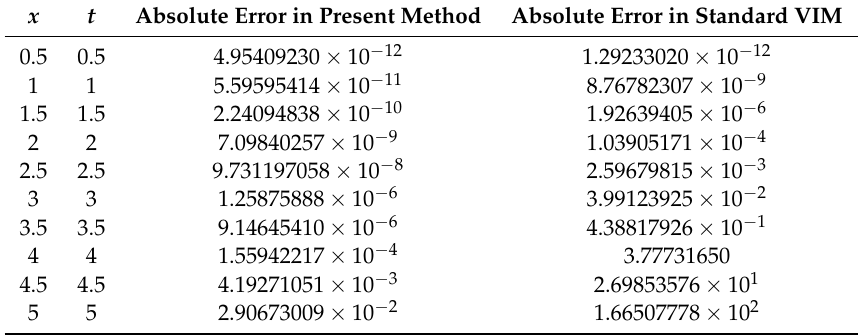
Table 2. Comparison of absolute errors for 16th-order approximation by present method with h = 1.264 and standard VIM, when α = 0.7 in Example